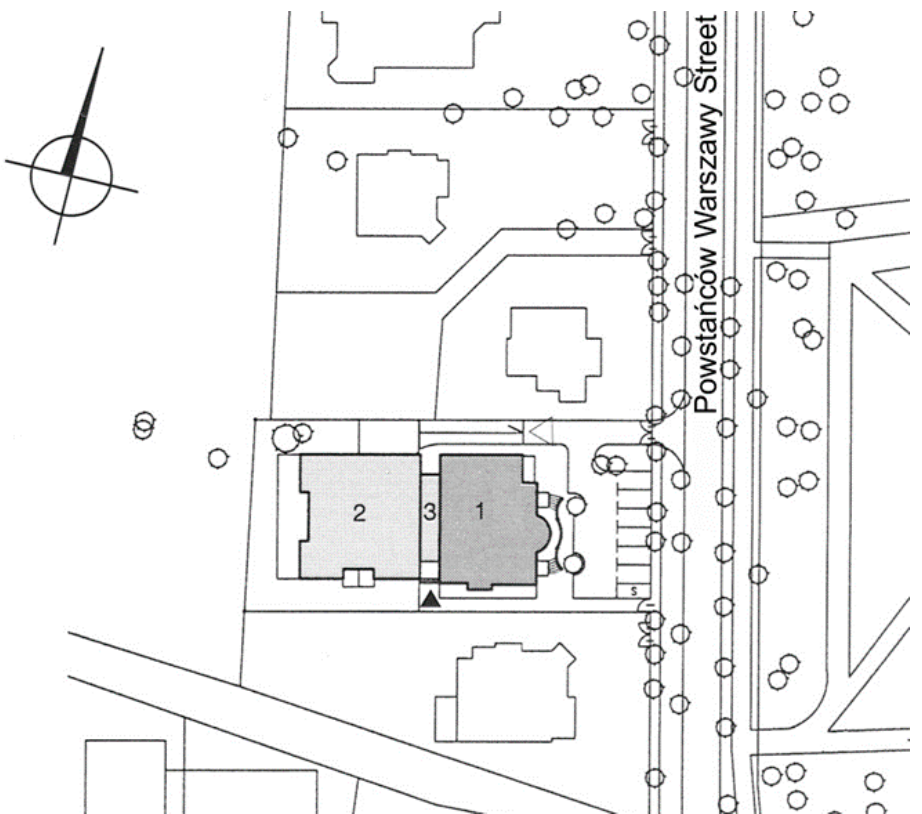
Figure 10. Willa Halina—(1) historic body of the building; (2) extended part; (3) Glazed hall. Source: A. Taraszkiewicz.